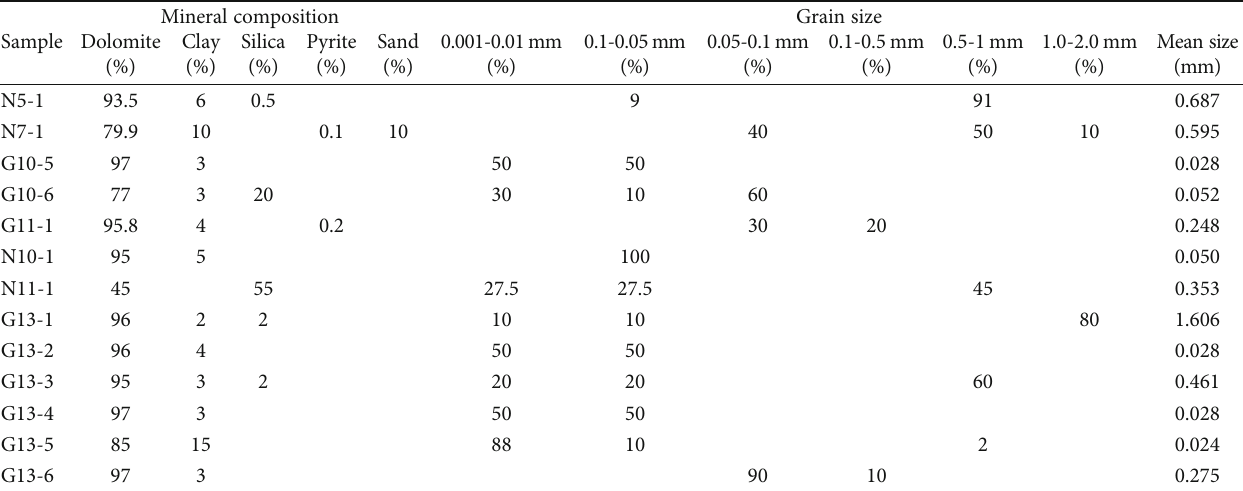
Table 5: Determination of the main mineral composition in dolomite rock slice.